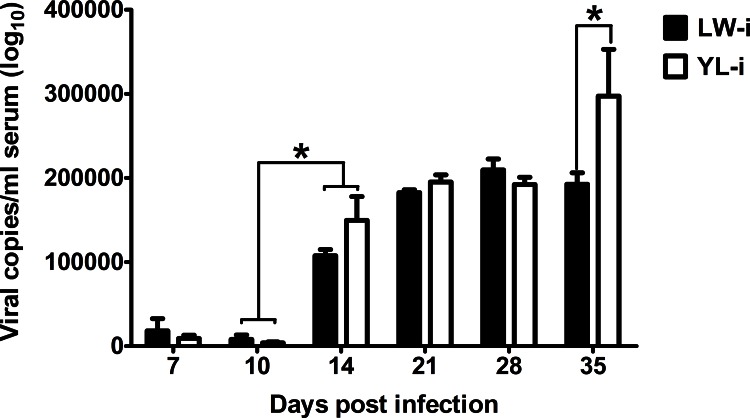
Changes in genomic copies of PCV2 in serum after PCV2 infection.The genomic copies of PCV2 in serum were determined through absolute quantitation PCR. Data were presented as the log10 transformed group means. The PCV2 copies of YL-i pigs were significantly higher than that of LW-i pigs at 35 dpi. * P < 0.05.